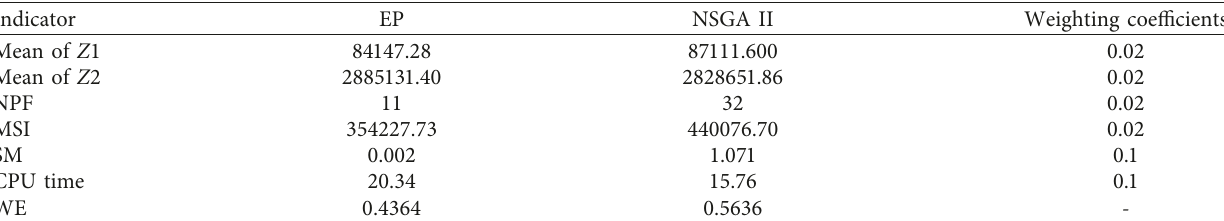
Table 12: Weighting coefficients of comparison indicators of solution methods.